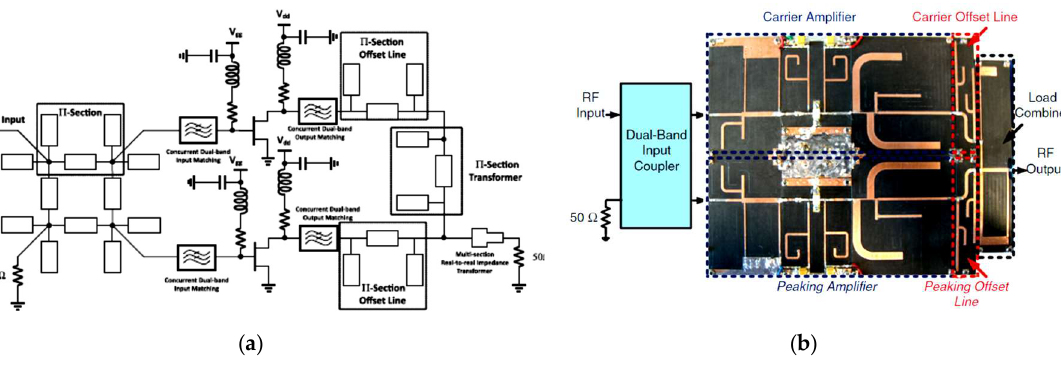
Figure 21. ( a ) Dual-band DPA architecture with Π -section structures [119]. ( b ) Dual-band DPA presented in [120].